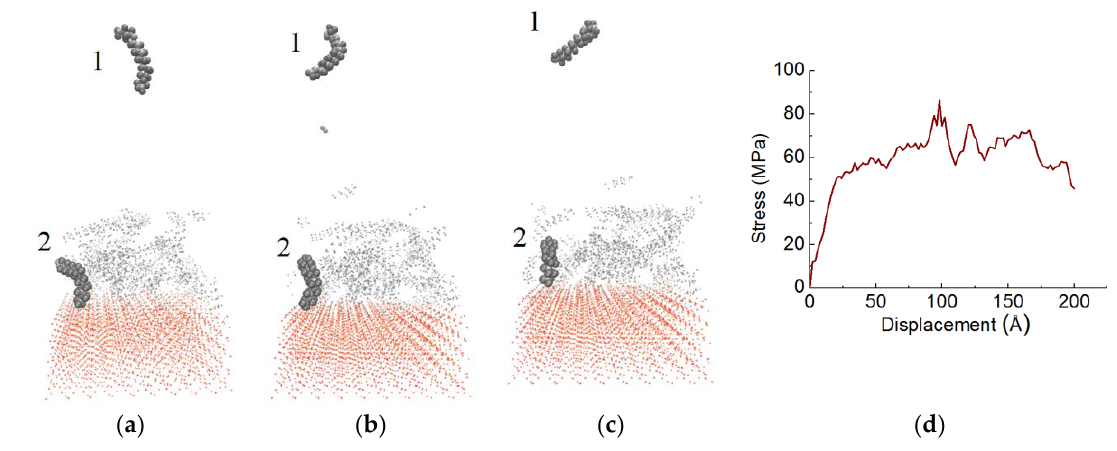
Figure 12. Snapshots of shear simulation of PE(150 – 40)/mS2 interface at various displacements: ( a ) 2 Å , ( b ) 100 Å , ( c ) 200 Å , ( d ) the stress curve.